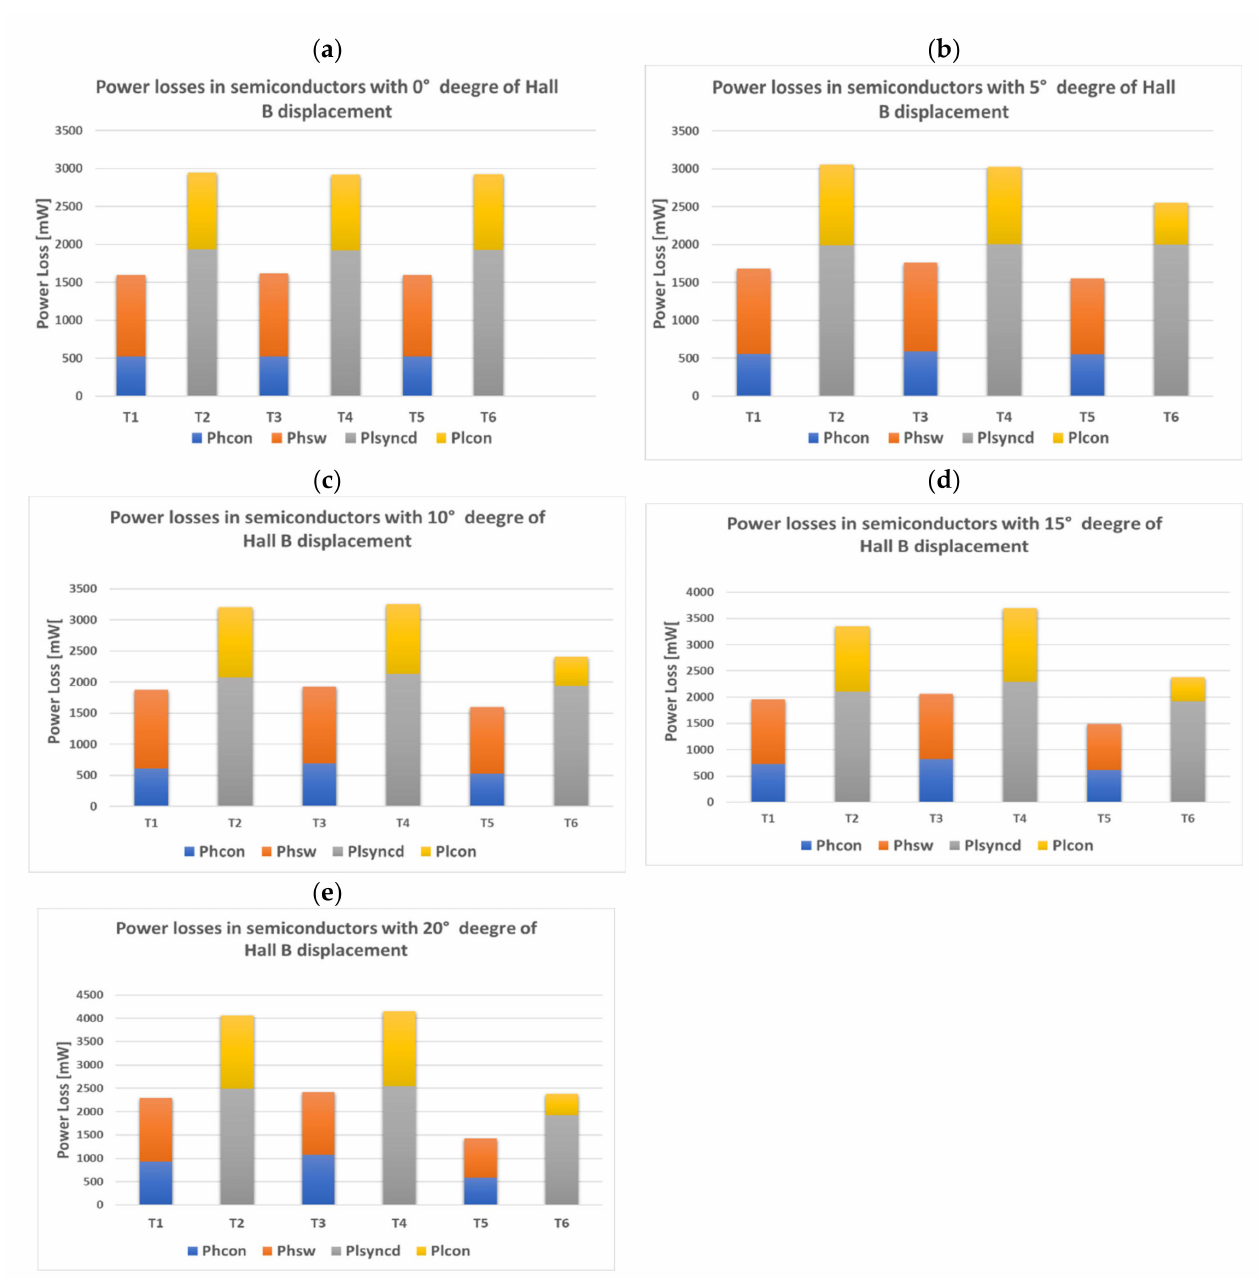
Figure 7. Top- and high-side switches division power loss of experimental results in the function of Hall B displacement: ( a ) 0 deg; ( b ) 5 deg; ( c ) 10 deg; ( d ) 15 deg; ( e ) 20 deg. Changing the position of the sensor increases the power losses on the transistors switched at a non-optimal moment of the rotor position in relation to the winding, but also makes the switches carrying the increased current work for longer (Figure 8). This additionally worsens the heat balance of the inverter transistors and makes it necessary to modify the method of determining the converter